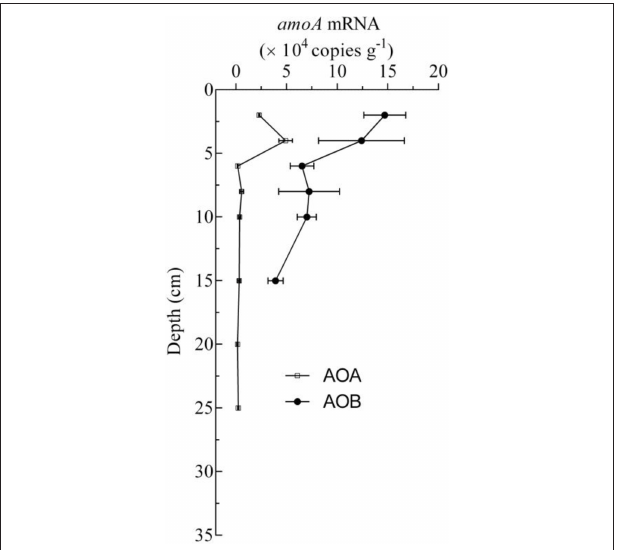
FIGURE 4 | Vertical distribution of transcripts of AOA and AOB amoA mRNA copy numbers in the sediment cores.